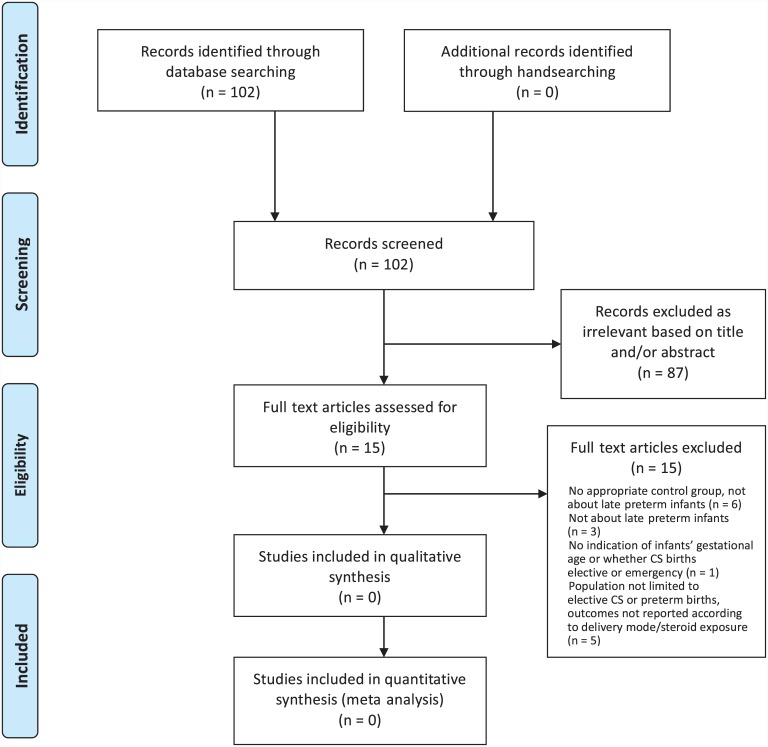
Flow diagram of search results and study selection for sub-question P2.